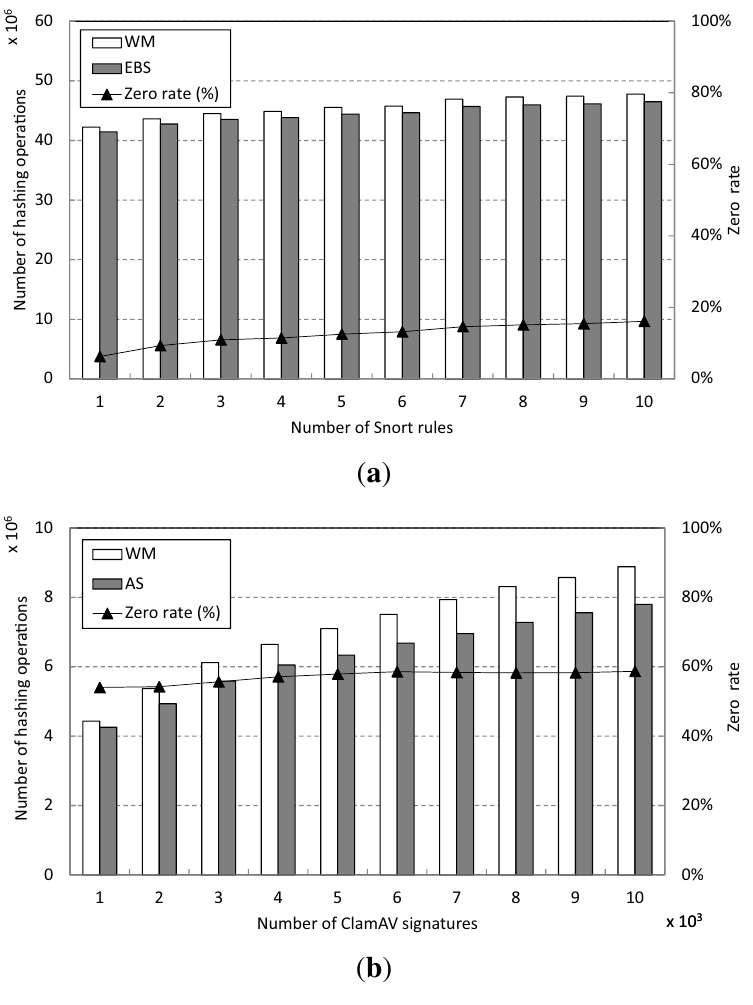
Figure 11. Number of hashing operations and zero rates for shifting operations. ( a ) Snort; ( b )